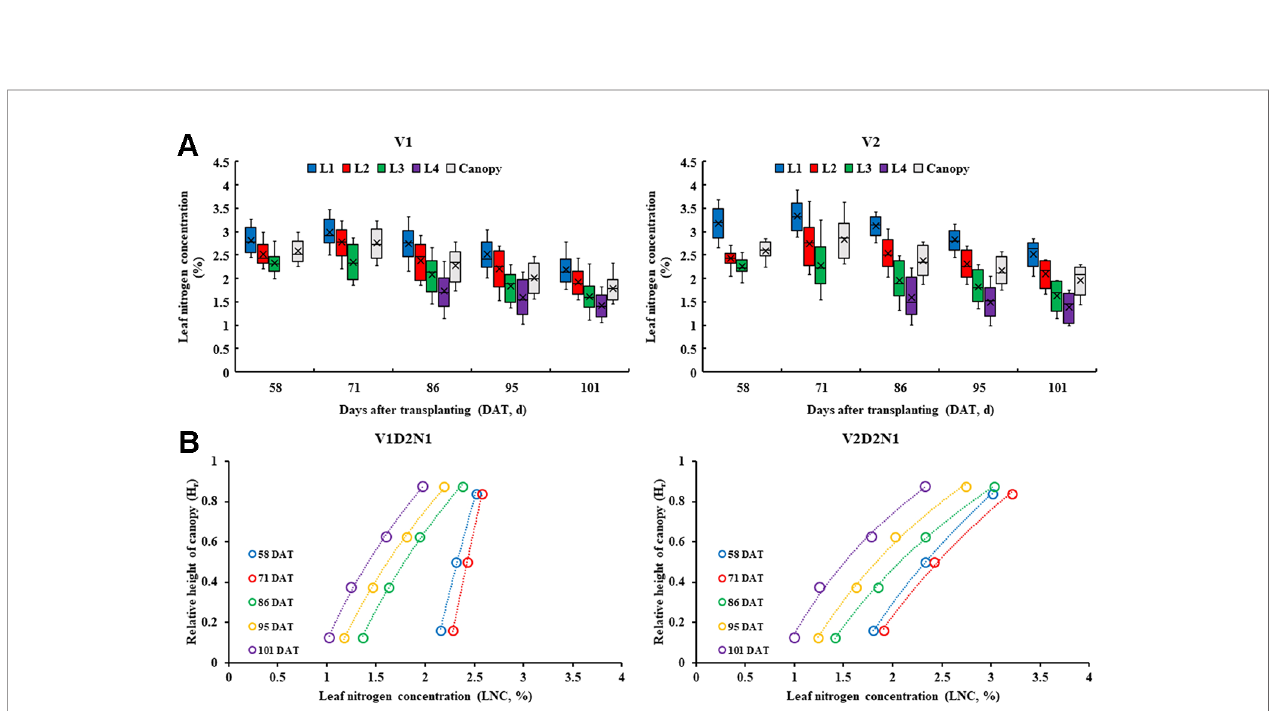
FIGURE 3 | Data distribution characteristics of the LNC Li and LNC Canopy at different growth period in 2015 (A) and the vertical distribution characteristics of the LNC in rice canopy, take V1D1N1 and V2D1N1 for example (B)